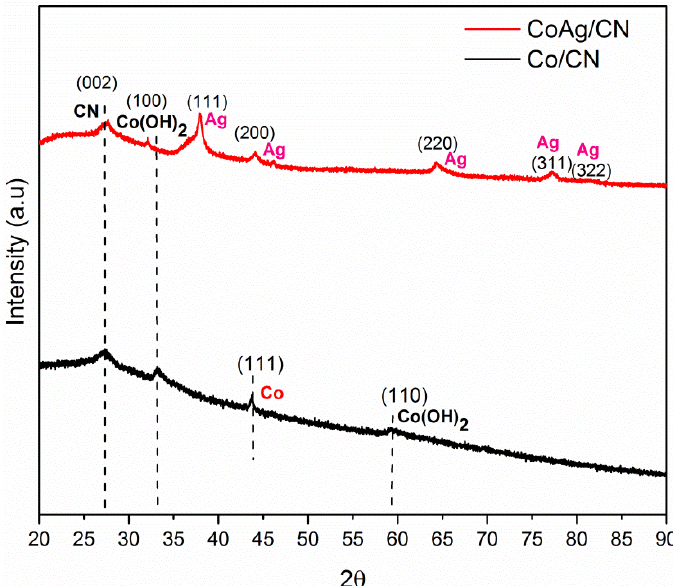
Figure 1. Powder X-ray diffraction patterns of Co/CN and CoAg/CN. During PXRD measurement, 2θ varies from 20–90° and the scanning rate was fixed at 2° per min.